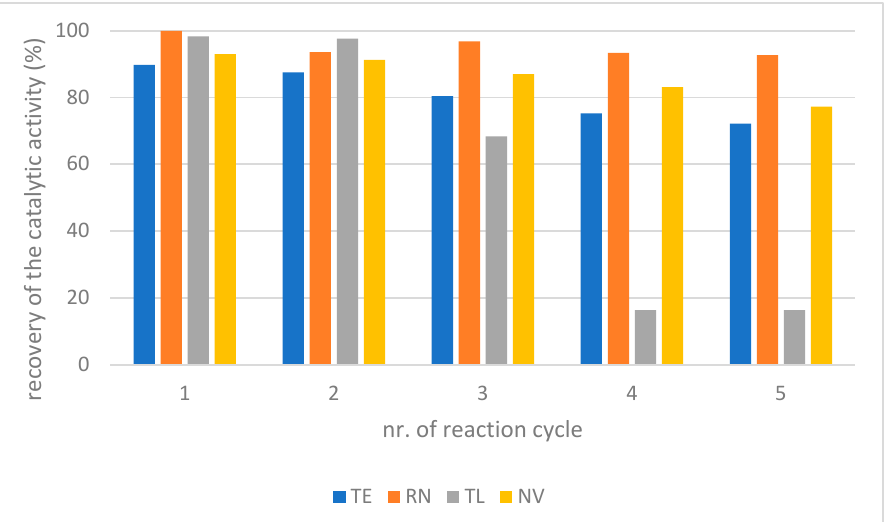
Figure 4. Working stability of the biocatalyst under optimum experimental conditions (1.58 mM MLE, L -menthol:MLE = 3:1 molar ratio, 1 mg/mL lipase biocatalyst in M:CA (I) reaction medium, 40 ◦ C temperature, 1000 rpm shaking and 24 h reaction time). Experimental conditions of the determination of biocatalyst activity: 2.5 mM p -NPB dissolved in ethanol, 1:4 v / v protein extract, and 32.5 mM Tris-HCl (pH 7.2) was incubated for 30 min at 37 ◦ C, and the reaction was terminated by addition of 20 mM Na 2 CO 3 blocking solution (10 min incubation). Triplicate measurements of the samples with maximum 23%